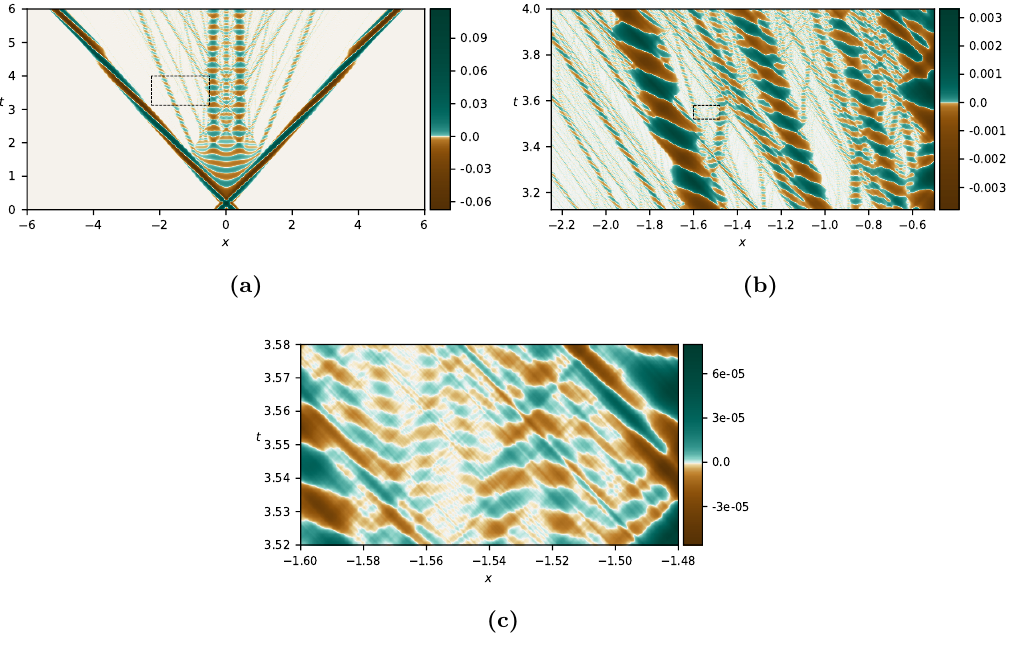
Figure 38 . Scattering process of two oscillons: (b) blow-up of the rectangular region in (a); (c) blow-up of the rectangular region in